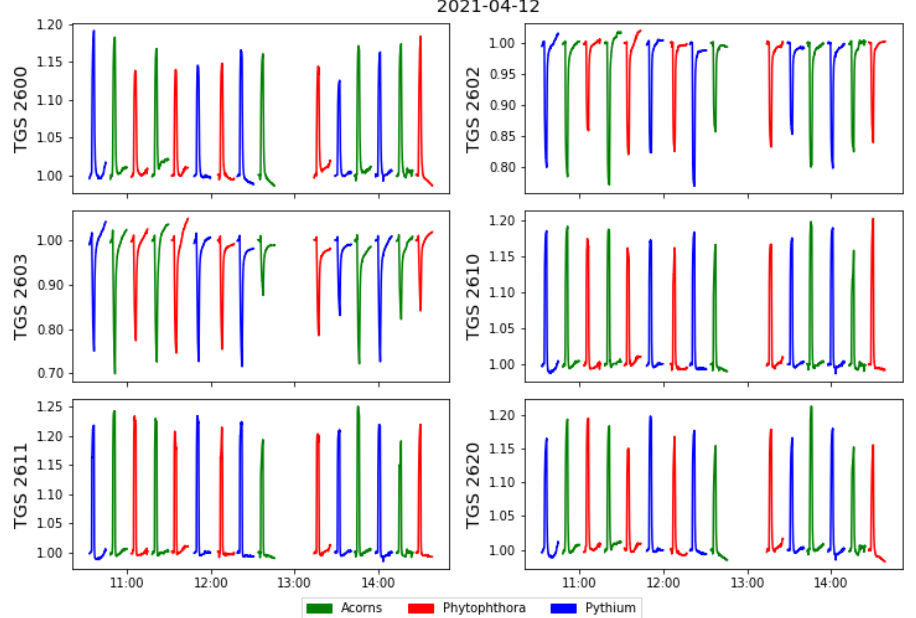
Figure 4. Example of all sensors responses collected during one day of the measurements, versus time of the measurement. The sensors’ responses are standardised by the baseline value obtained as the average of sensors values when exposed to the clear air conditions at the beginning of each measurement